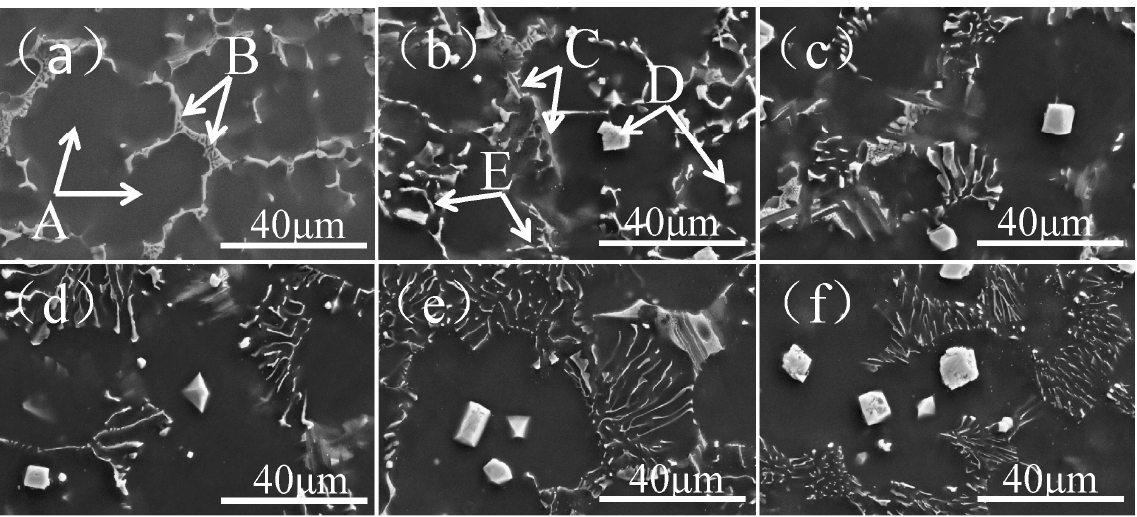
Figure 2. SEM images of as-cast Mg-11Gd-2Y-1Zn-xAl alloys. ( a ) x = 0; ( b ) x = 1; ( c ) x = 2; ( d ) x = 3; ( e ) x = 4; ( f ) x = 5. Table 2. The energy spectrum analysis results of typical second phases in Figure 2 (at.%).